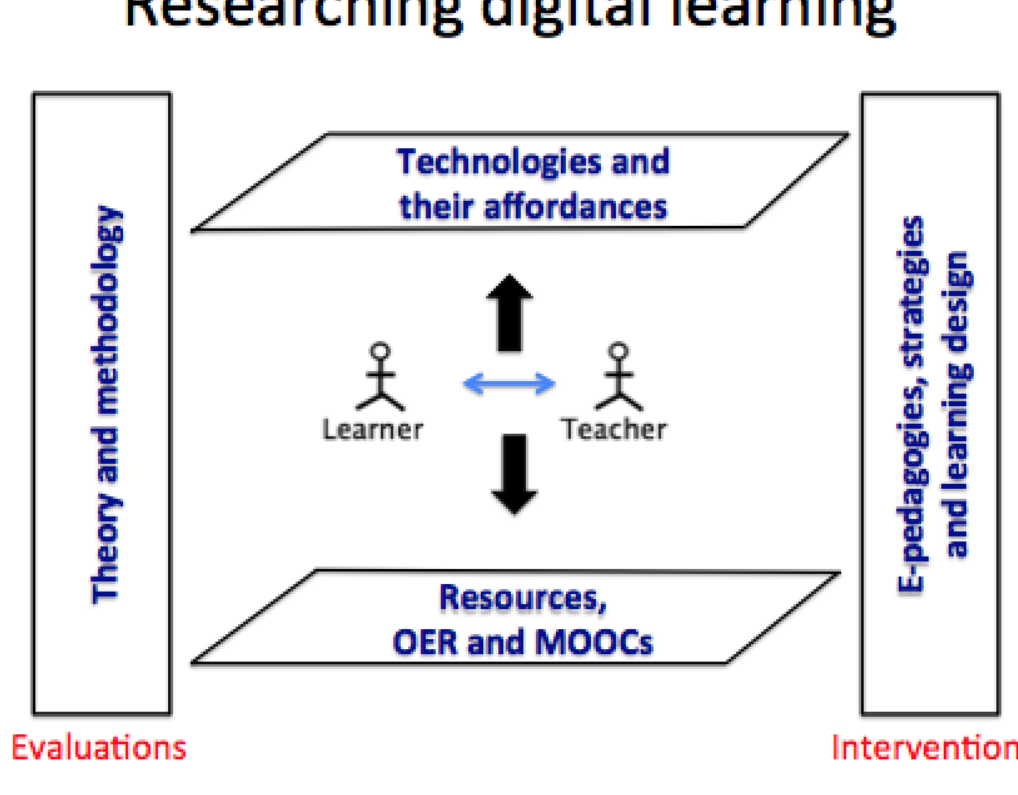
Figure 3: The key components of researching digital